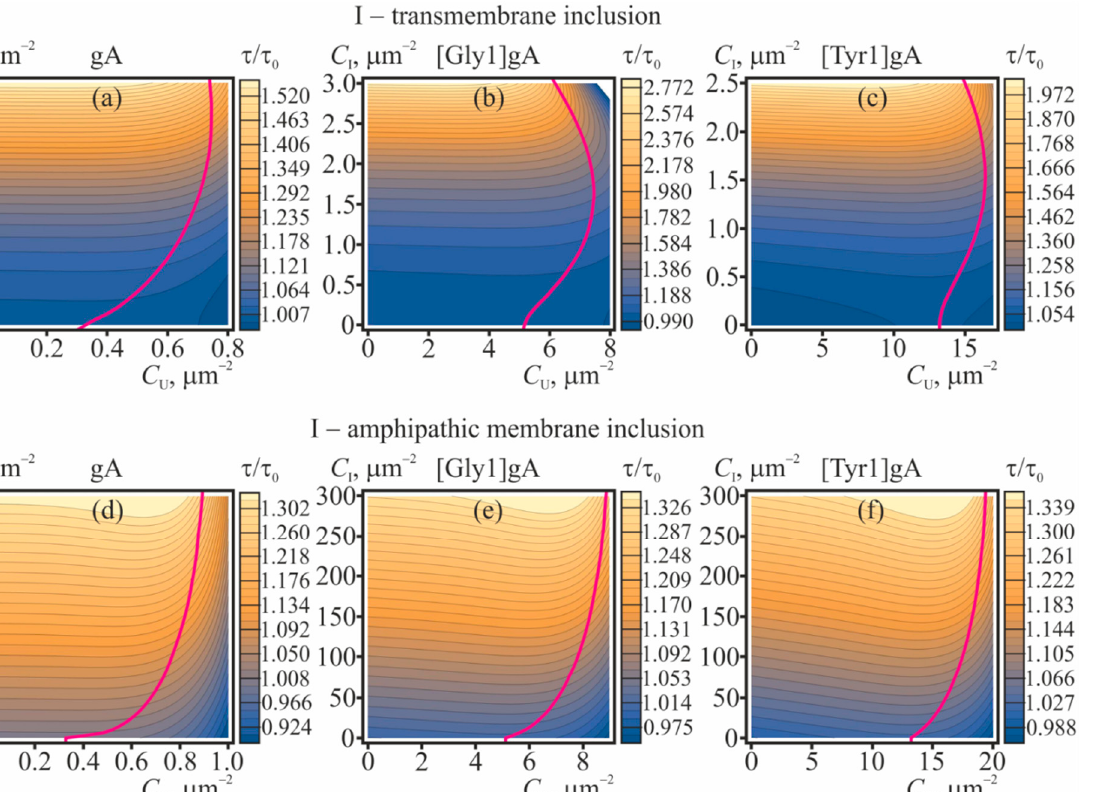
Figure 6. The dependence of the relative lifetime, τ / τ 0 , of the solitary conducting dimer on ( a )—concentration of transmembrane inclusions; ( b )—concentration of amphipathic membrane inclusions (incorporated into the top monolayer). The dependencies were obtained based on Equation (31). The magenta dotted lines bound the range of concentrations where the correction to the main approximation calculated within the perturbation theory reaches 20%; for larger C I con- centrations the application of the perturbation theory is not strictly valid.